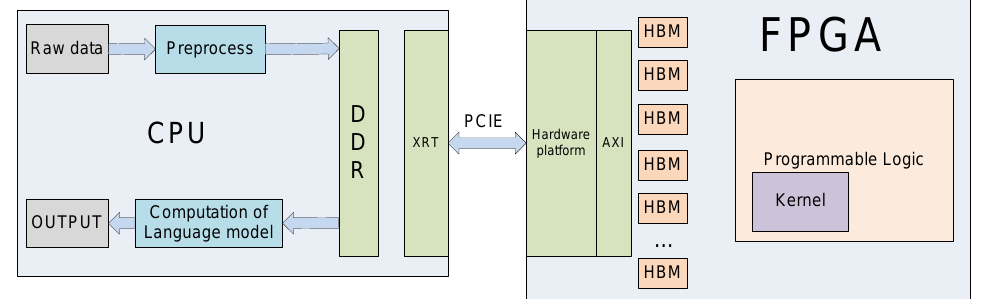
Figure 2. The overall